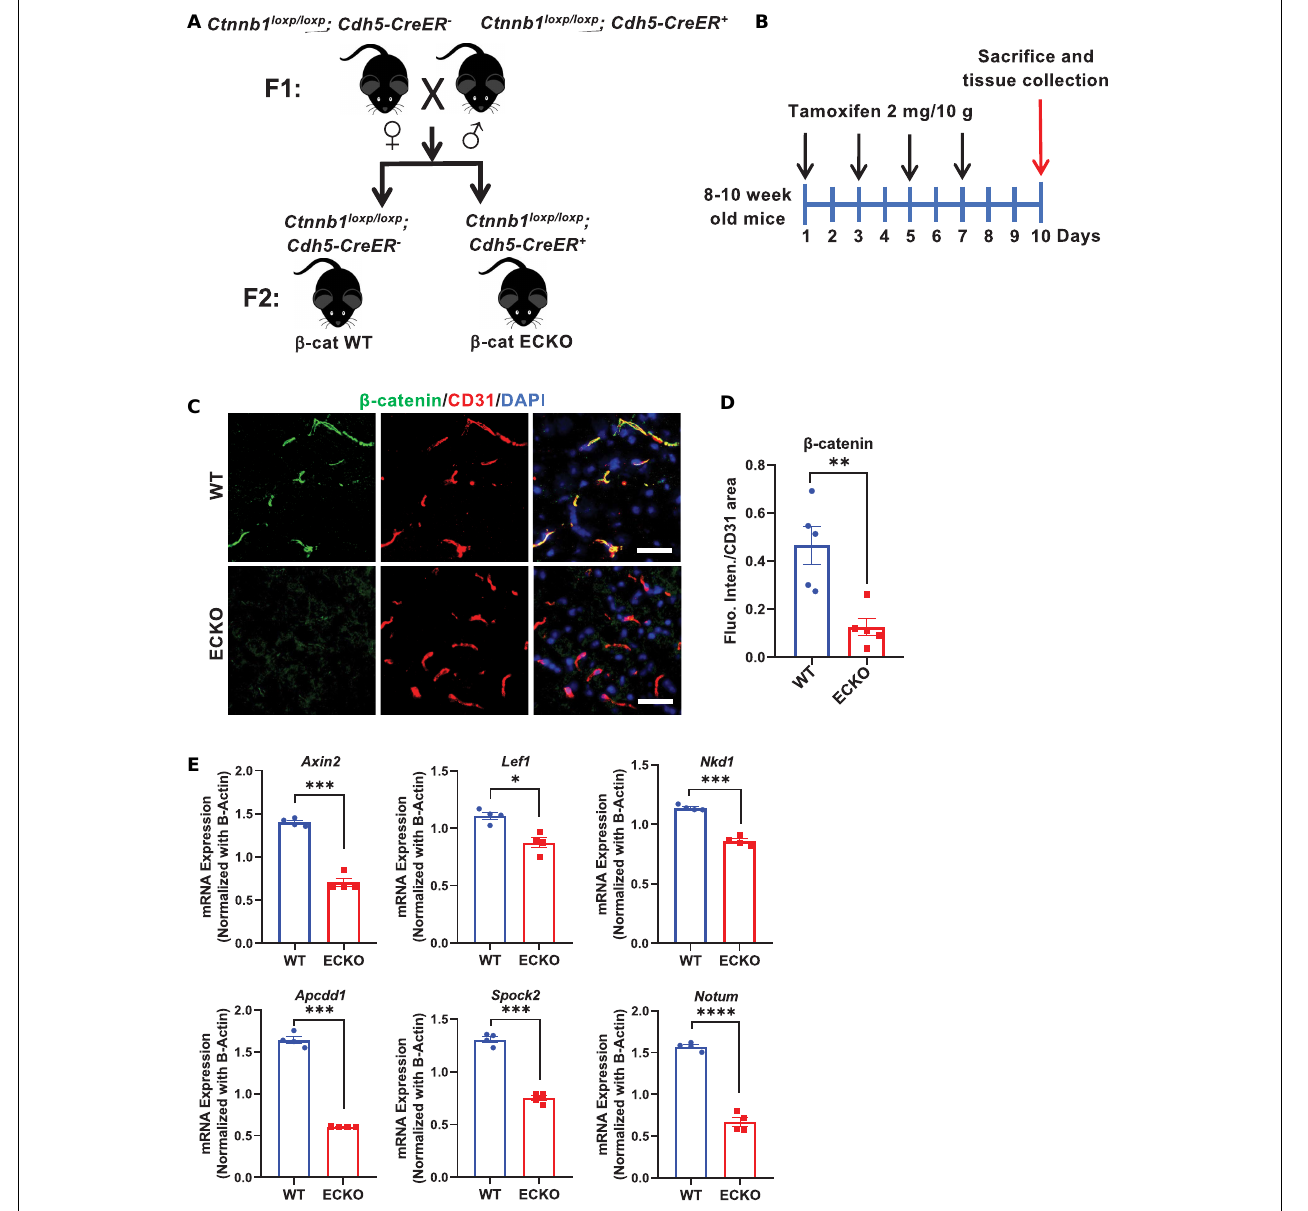
FIGURE 1 | Endothelial cell-specific deletion of β -catenin suppresses the activity of endothelial Wnt/ β -catenin signaling in adult mice. (A) Crossing of mice carrying Ctnnb1 loxp / loxp ; Cdh5-CreER - allele with mice harboring Ctnnb1 loxp / loxp ; Cdh5-CreER + allele to produce β -cat ECKO mice and β -cat WT control, respectively. (B) Schematic of the experiment design. (C) Immunofluorescence staining showing the expression pattern and levels of active β -catenin (non-phosphorylated form) in the cerebral cortex from β -cat WT mice and β -cat ECKO mice, respectively. Scale bars: 100 µ m. (D) Quantification of the fluorescence intensity of active β -catenin normalized with CD31 area. (E) Relative mRNA expression levels of Wnt/ β -catenin signaling target genes: Axin2, Lef1, Nkd1, Apcdd1, Spock2, and Notum normalized with β -actin . Data are mean ± SD. n = 4–5 mice per group. Significance of data is represented as: ∗ P < 0.05, ∗∗ P < 0.01, ∗∗∗ P < 0.001, ∗∗∗∗ P <